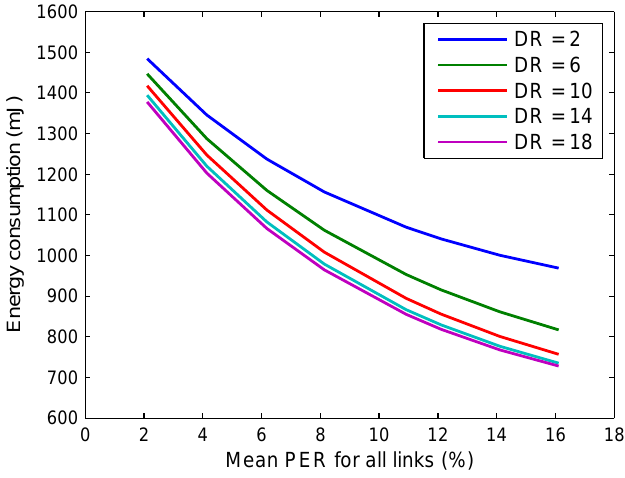
Figure 9. Energy consumption for different values of Data Relevance